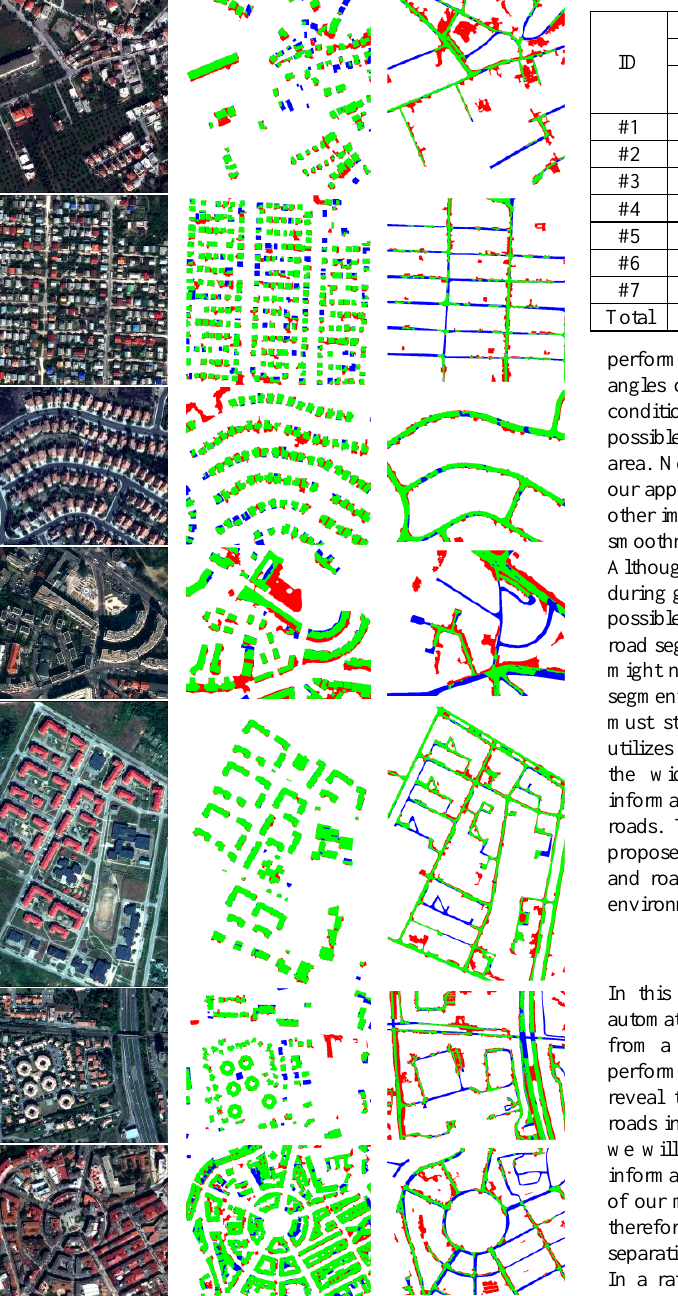
Figure 5. (first column) Test dataset (#1-7, RGB), (second column) the results of building regions, and (third column) the results of road regions. Green, red and blue colours represent true-positive, false-positive and false-negative, respectively.